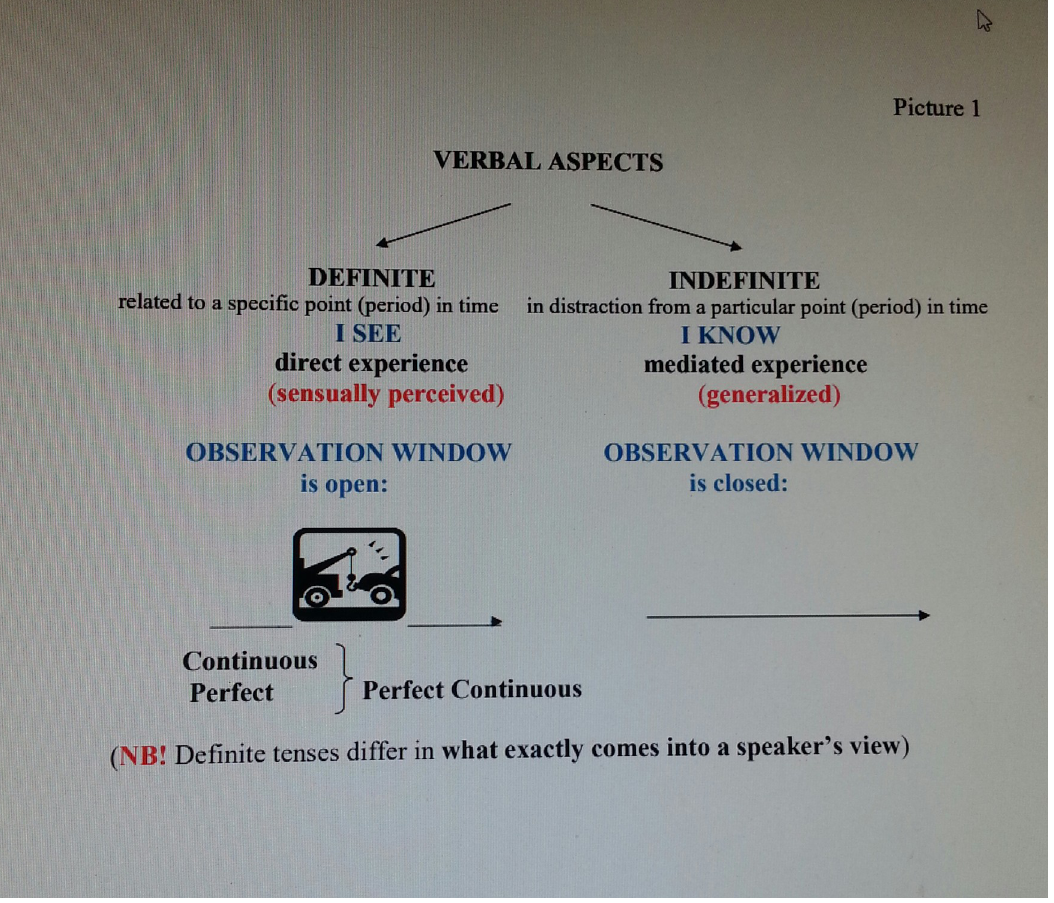
Figure 1 - Verbal aspects ("OBSERVATIONAL